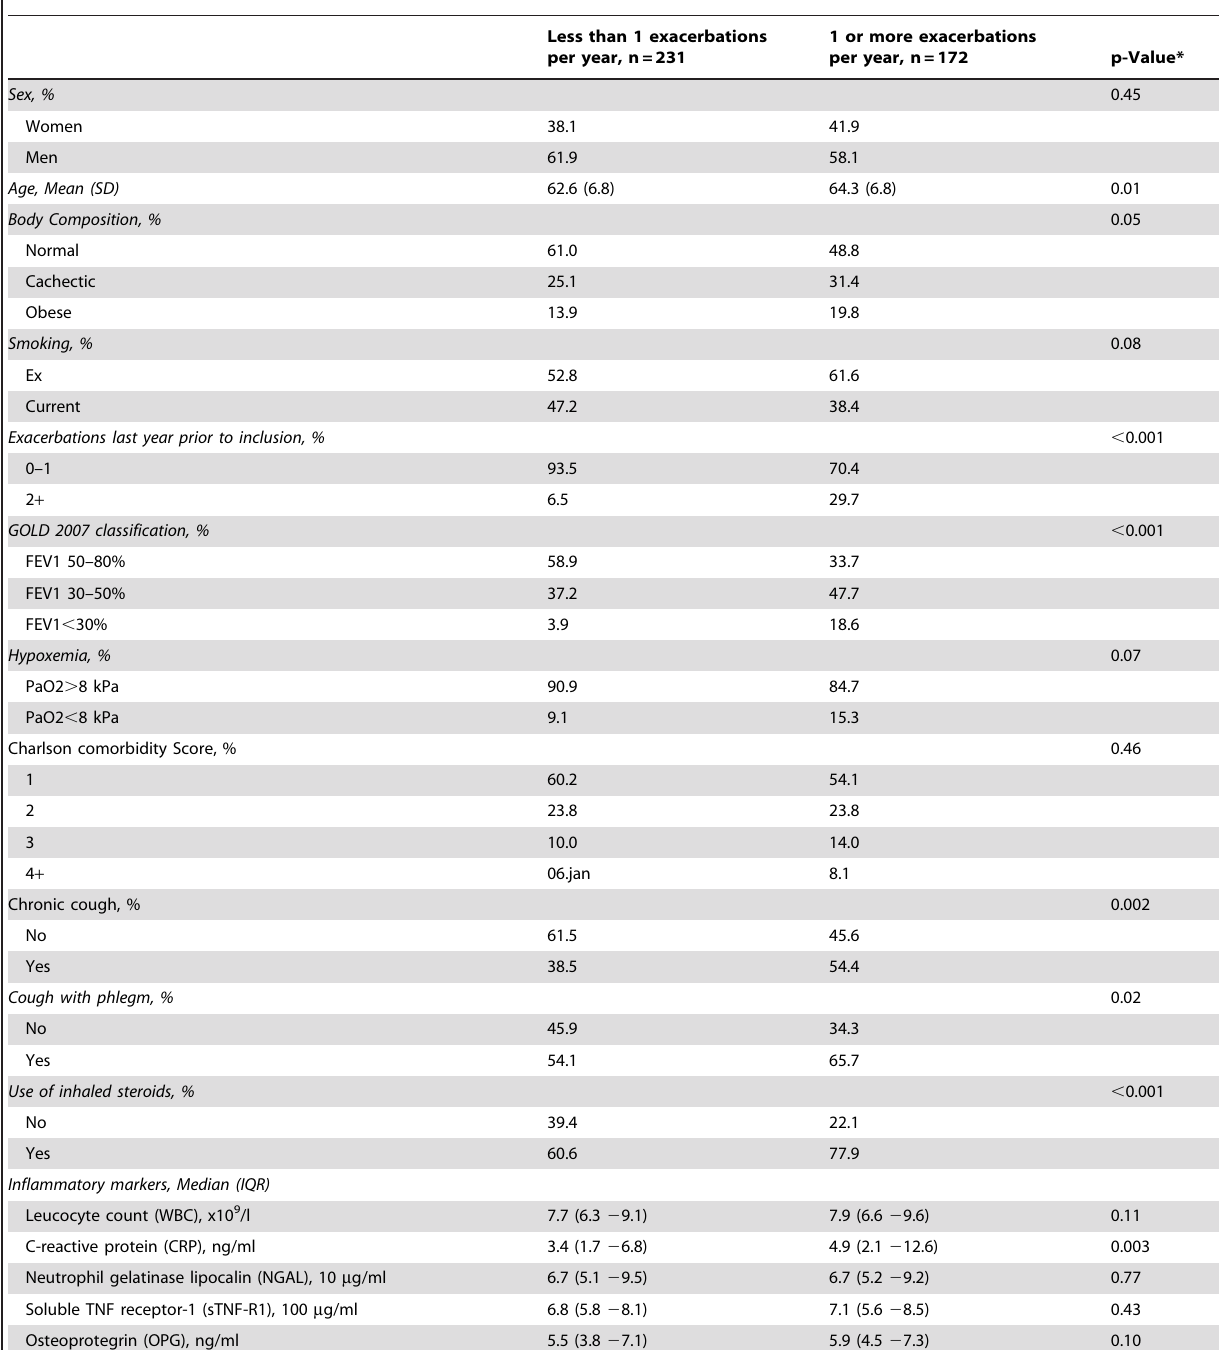
Table 1. Characteristics of COPD patients according to exacerbation frequency during follow-up.